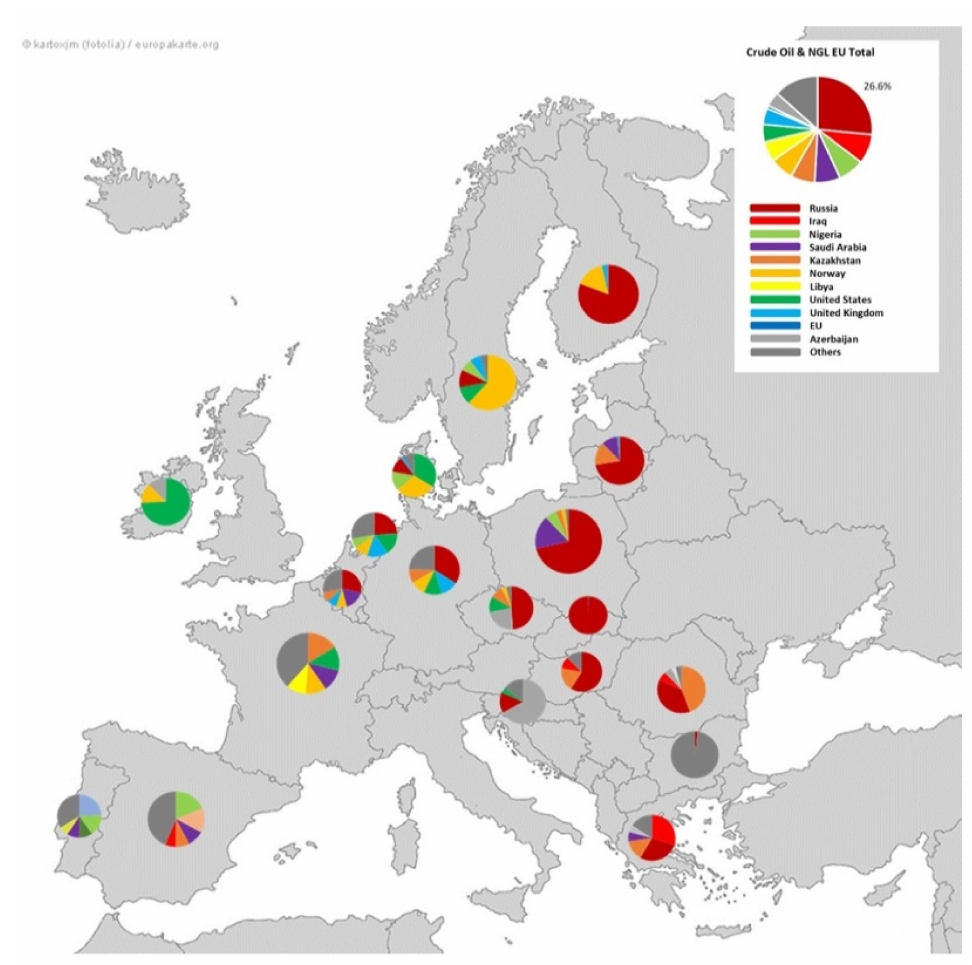
Figure 4. Share of EU import origin for natural gas and crude oil (authors’ elaboration on Eurostat